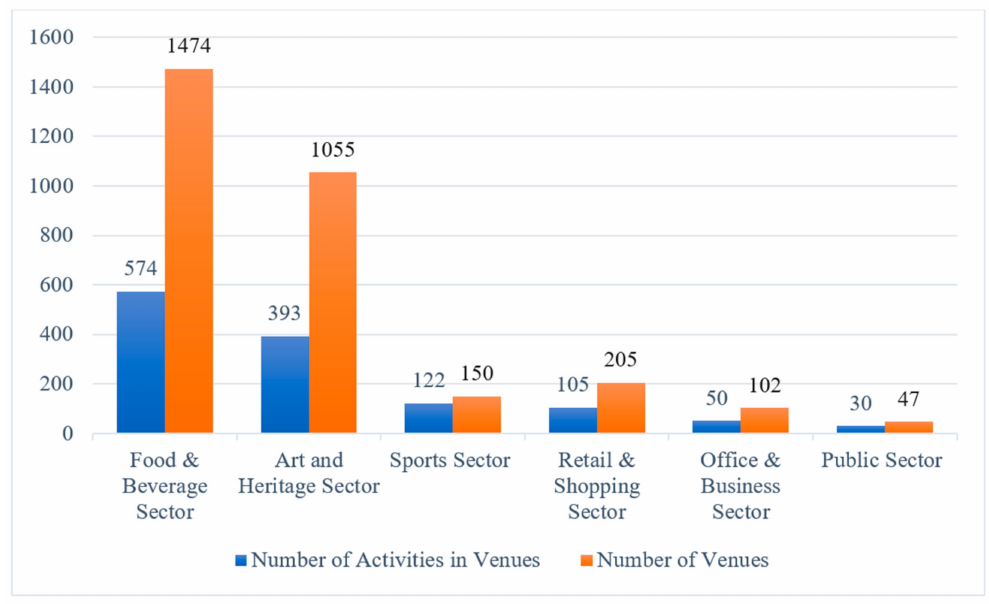
Figure 3. Numbers of venues and activities held in six